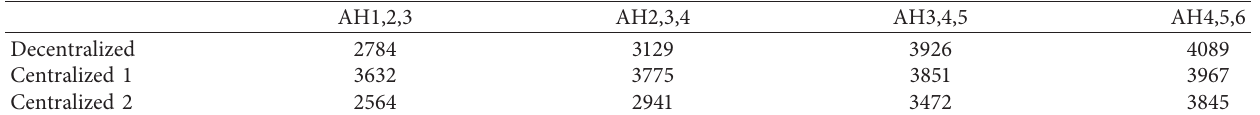
Figure 4: Rate comparison (data volume). Table 2: Rate comparison (data volume).